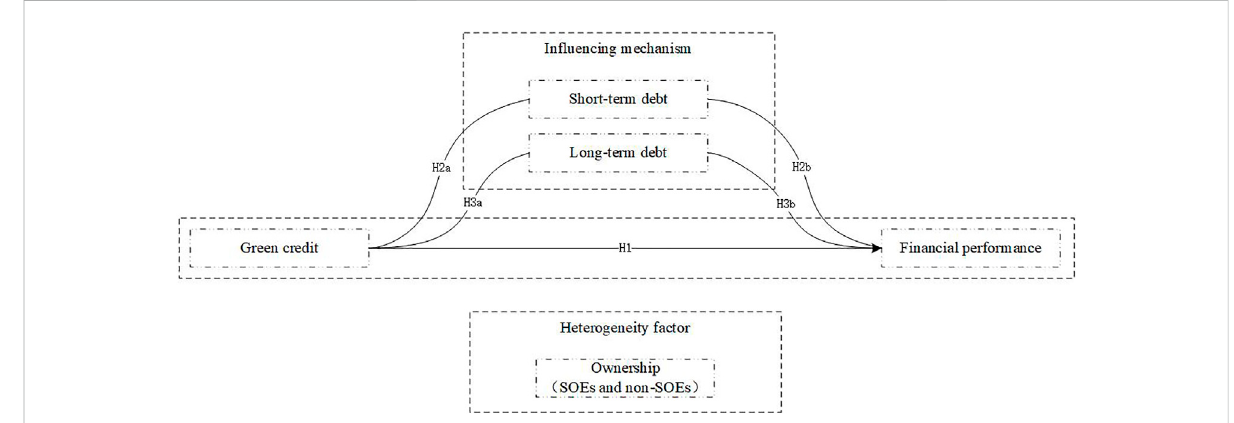
FIGURE 1 Logical diagram of the relationship between green credit and fi nancial